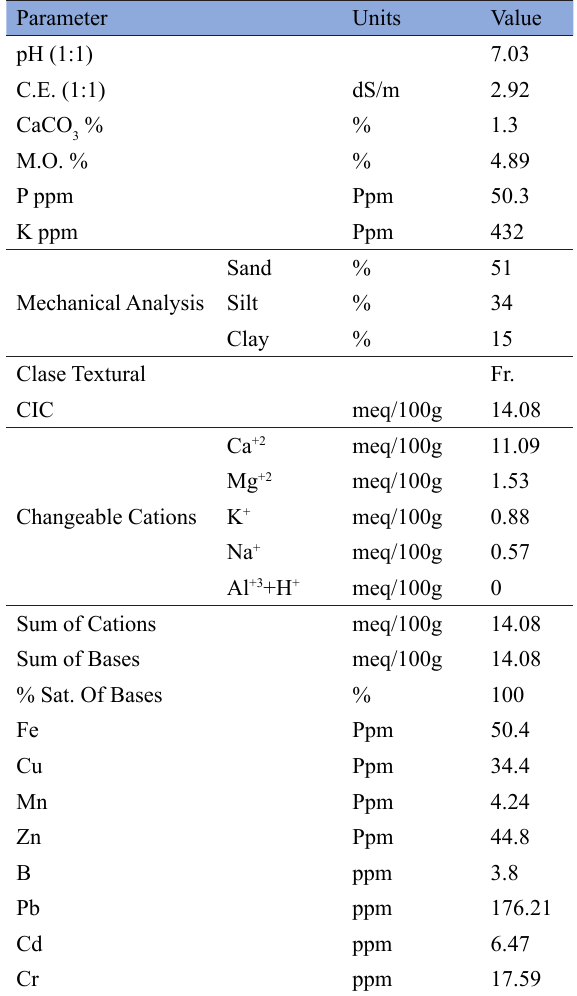
Table 4 : Characteristics of the soil of Huachipa Zoological Park